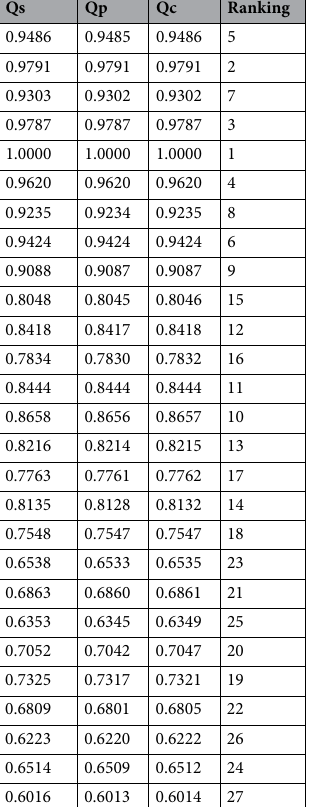
Table 8. Generalized criteria and optimal